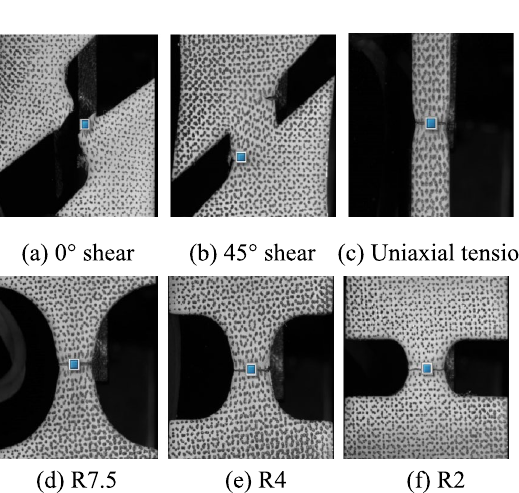
Figure 3 Fracture morphology and measured fracture strain under different stress states